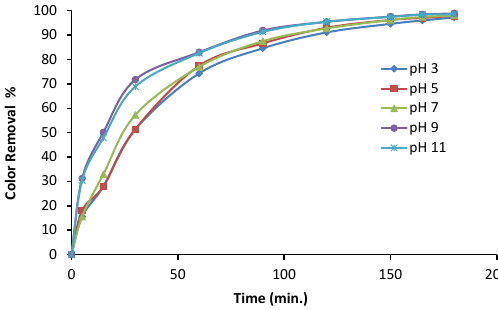
Time (min.) Fig. 2. Color reduction of the Direct Yellow 12 versus contact time at different pH (3, 5, 7, 9 and 11), (Dye concentration = 100 mg/l, O = 500 mg/h, treated volume = 200 3